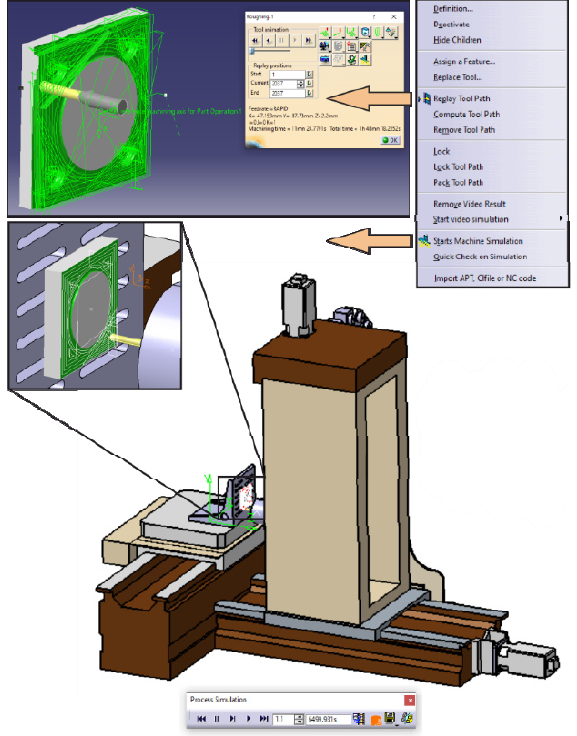
Figure 7. Virtual machine simulation in CATIA